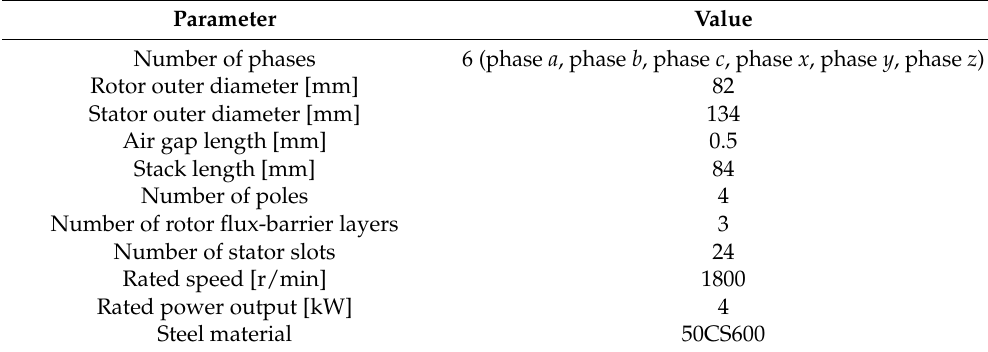
Table 1. Initial design of motor